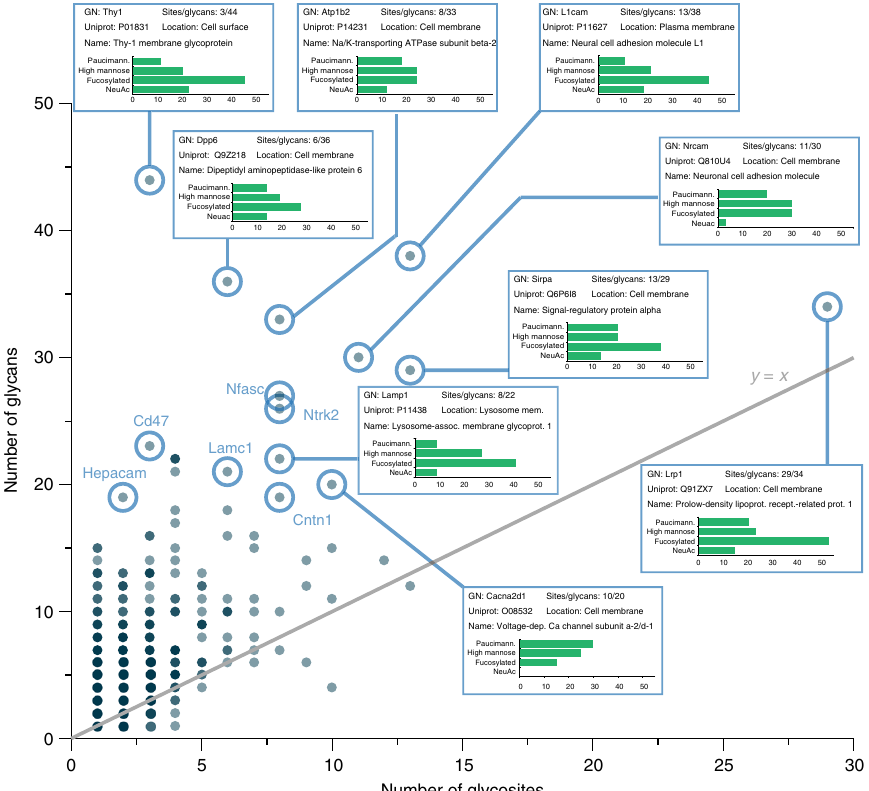
Fig. 4 Glycan heterogeneity by glycoprotein. A scatter plot showing the number of glycans identi fi ed per glycoprotein vs. the number of glycosites identi fi ed for that protein summarizes a degree of glycosylation heterogeneity at the protein level. An y = x line is shown in gray to provide an eye guide for proteins that had a particularly high number of glycans relative to the number of glycosites identi fi ed, some of which are highlighted. Boxes for highlighted proteins display gene name (GN), UniProt accession number, number of glycosites/glycans identi fi ed, the cellular location assigned to this protein, and a common name for the protein. Additionally, they provide a bar chart that displays the percentage of the total number of identi fi ed glycans (i.e., the x -axis) that can be classi fi ed as paucimannose, high mannose, fucosylated, or sialylated (NeuAc). Note, if a paucimannose or sialylated glycan was fucosylated, it was also counted as fucosylated for this calculation. Gene names of other interesting proteins with a high glycan-to-glycosite ratio are also